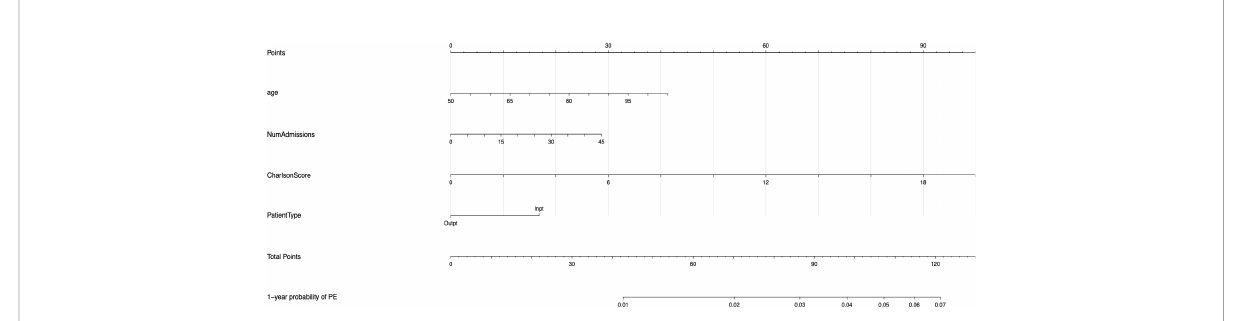
FIGURE 3 Nomogram for predicting the 1-year probability of PE in patients with GCA. NumAdmissions, number of admissions; Outpt, outpatient; Inpt, inpatient.